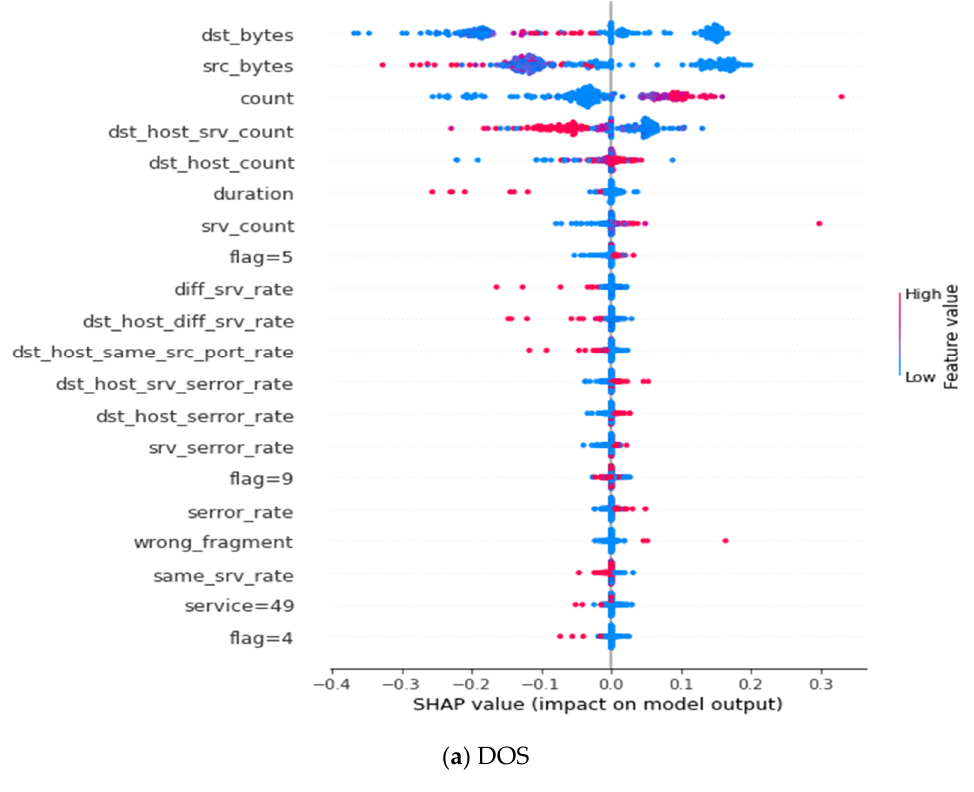
Figure A5. PGD robustness test against FGSM attacks.